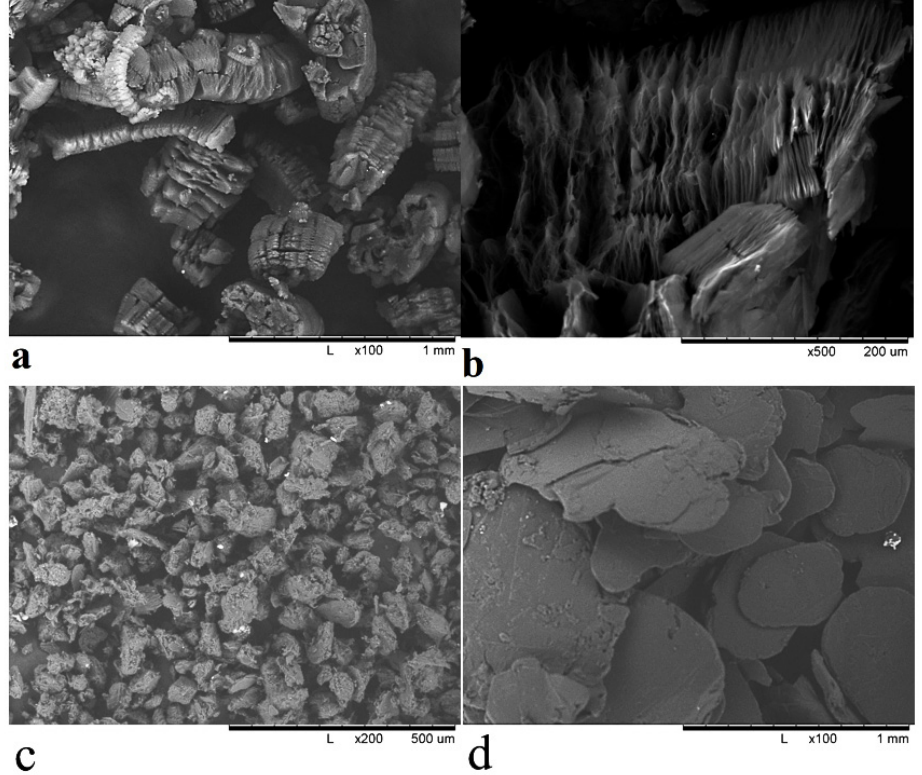
Figure 1. Scanning electron microscopy (SEM) images of: thermoexpanded graphite (EG) ( a , b ); artificial graphite (AG) ( c ); natural graphite (NG) ( d ).